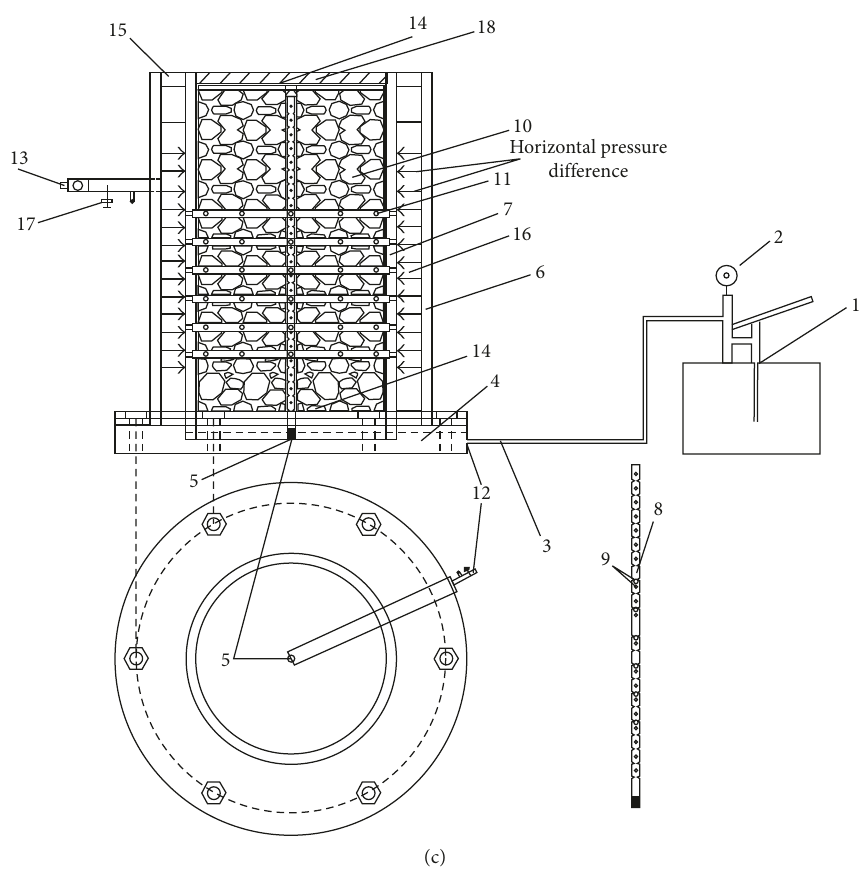
Figure 3: (a) Self-developed grouting experimental apparatus, (b) inner cylindrical grouting barrel used for the placement of the crushed coal sample, and (c) part of the schematic layout of this grouting experimental equipment:1: controllable grouting pump; 2: pressure gauge; 3: external grouting pipe; 4: bottom plate; 5: grouting hole on the bottom plate; 6: outer grouting barrel; 7: inner grouting barrel; 8: grouting steel tube; 9: small grouting holes on the surface of the grouting steel tube; 10: test specimen; 11: fine holes attached to the sidewall of the inner barrel; 12: bottom valve; 13: outlet; 14: seal rings; 15: sealing plug; 16: channel between the inner and outer barrels; 17: safety valve on the outlet; 18: load-bearing